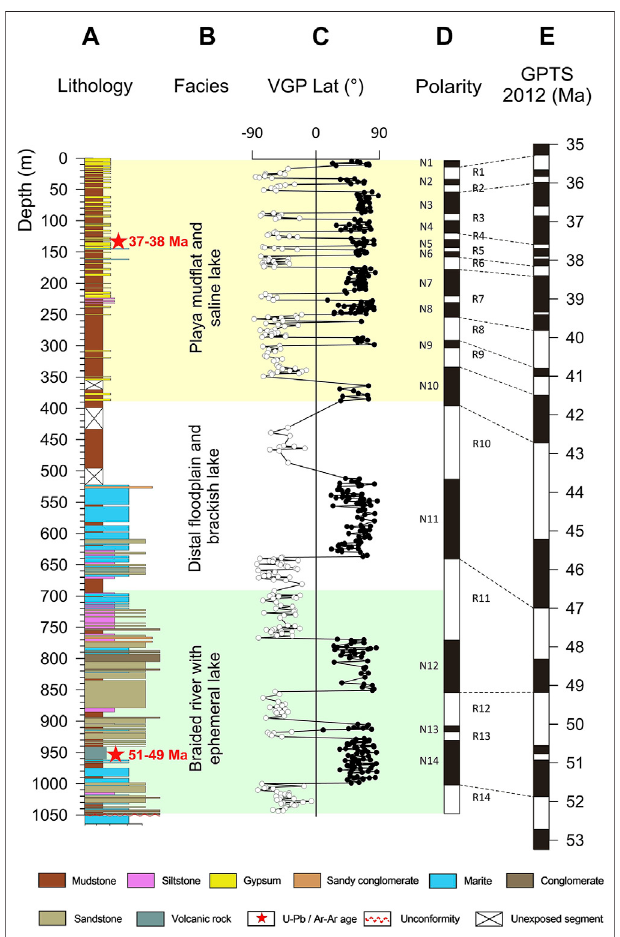
FIGURE 2 | Lithofacies (A) and sedimentary facies (B) of the Paleogene sedimentary sequence in the NB. The magnetostratigraphy (C – E) is modi fi ed from the work of Zhang et al. (2020). The Ar – Ar and U – Pb ages are from the workofHortonetal.(2002),Spurlinetal.(2005),andZhangetal.(2020).